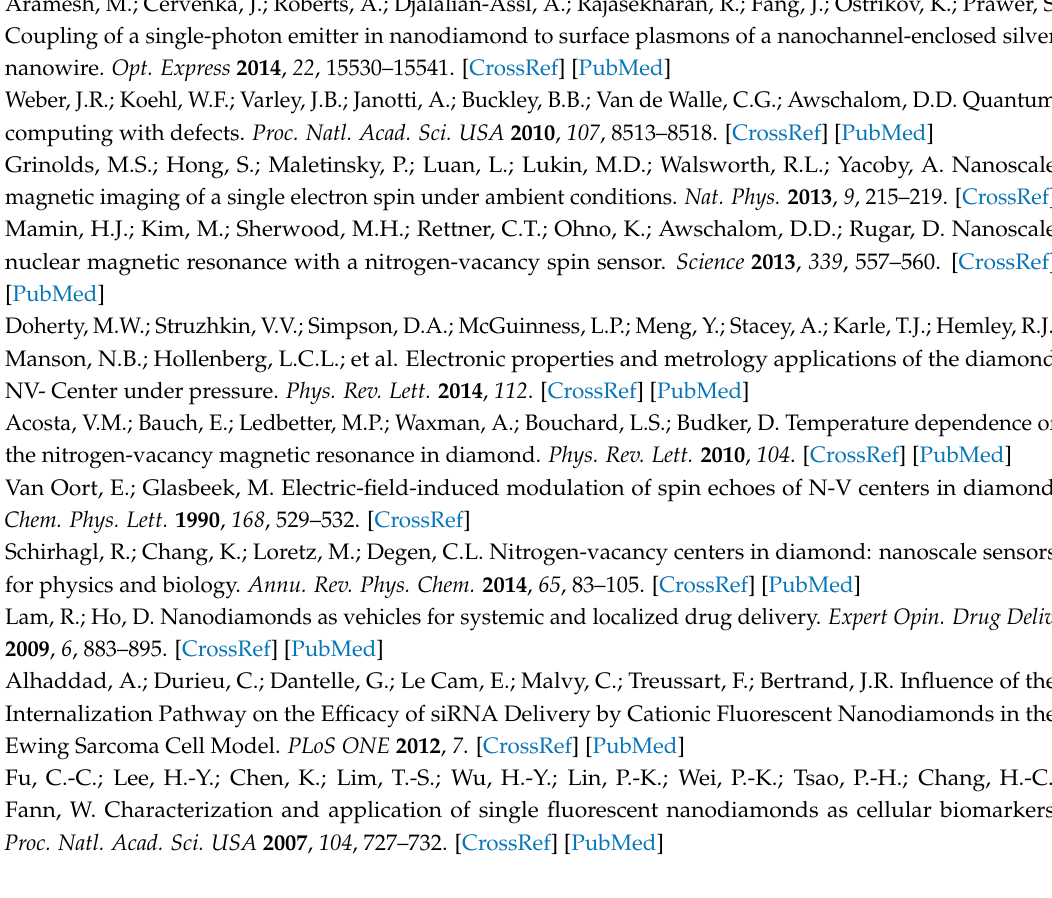
Supplementary Table S1: Antibodies for Western Blot, Supplementary Table S2: Simplified comparison of Western Blot and qPCR results, Supplementary Figure S1: Confocal images of HeLa cells used for particle and object counting (3 pages), Supplementary Figure S2: Free radical production after stimulation using LPS, Supplementary Figure S3: Viability of HeLa cells after 24 h stimulation using different concentrations of LPS, Supplementary Figure S4: Mean free radical production of nanodiamonds, Supplementary Figure S5: Morphological comparison between different concentrations of FND70 directly after uptake, 24 h after uptake and 48 h after uptake (4 pages) and Supplementary Table S3: Summary of morphological